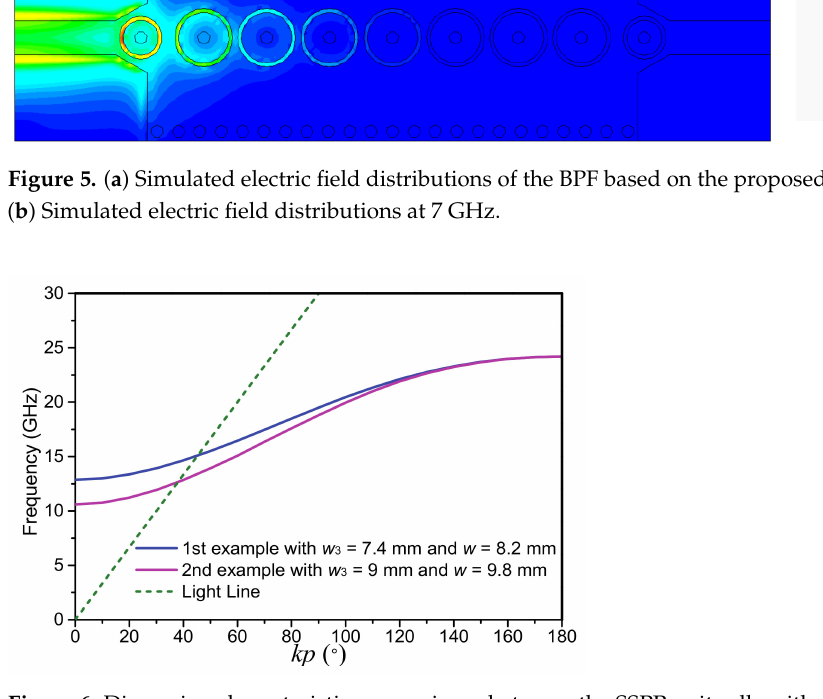
Figure 6. Dispersion characteristic comparisons between the SSPP unit cells with w 3 = 7.4 mm and w = 8.2 mm, and w 3 = 9 mm and w = 9.8 mm.